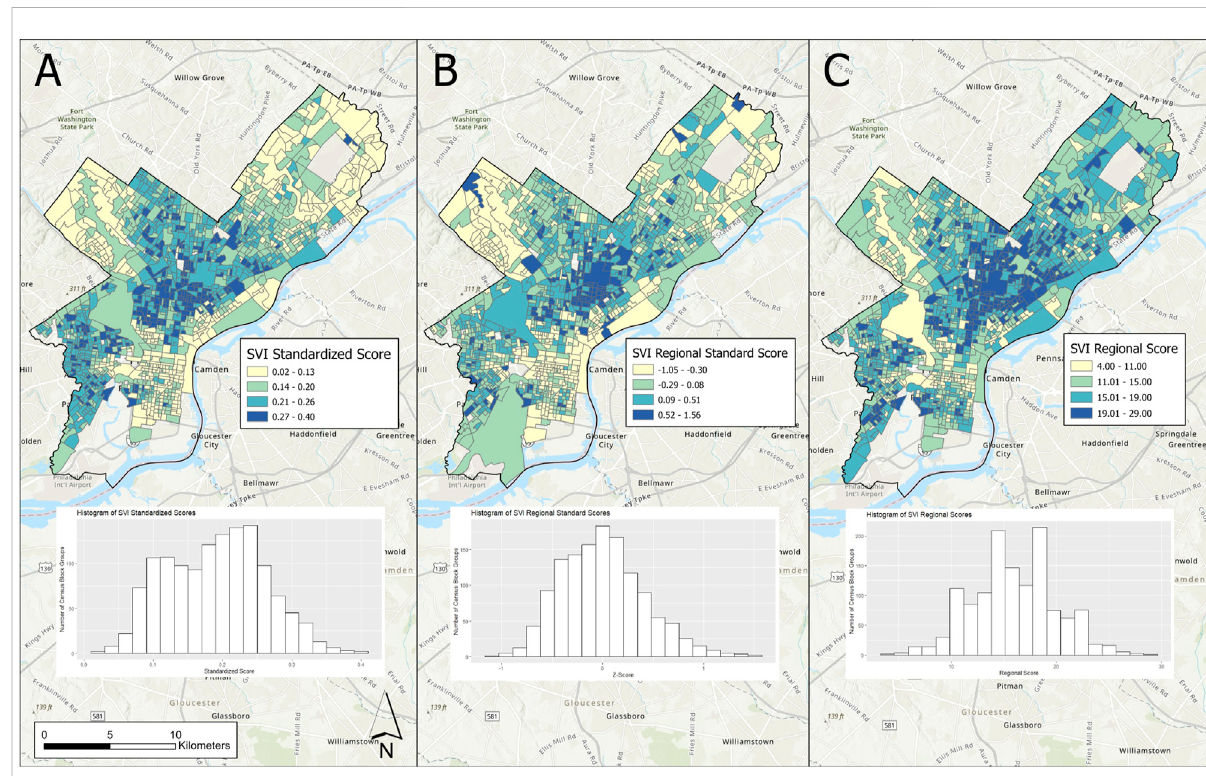
FIGURE 4 The analysis of the Social Vulnerability Index results. (A) The spatial distribution of the SVI based on the standardized scoring method. (B) The spatial distribution of the SVI based on the z-scores. (C) The spatial distribution of the SVI based on the regional scoring method. Base Map Source: Esri, DeLorme, HERE, TomTom, Intermap, increment P Corp., GEBCO, USGS, FAO, NPS, NRCAN, GeoBase, IGN, Kadaster NL, Ordnance Survey, Esri Japan, METI, Esri China (Hong Kong), swisstopo, MapmyIndia, and the GIS User